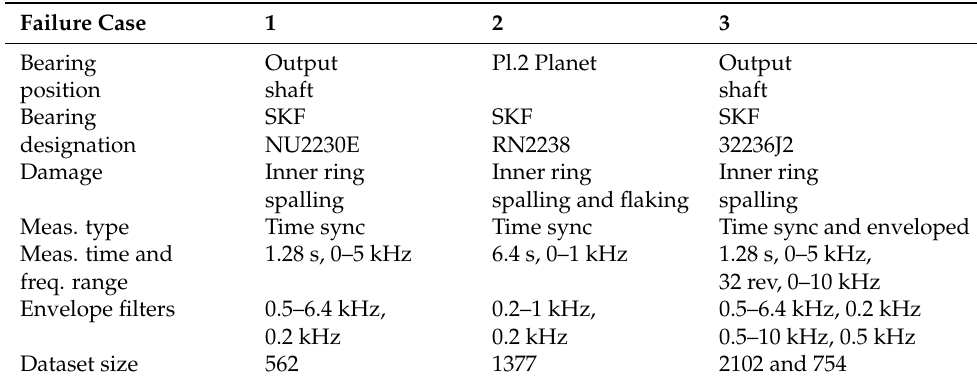
Table 1. Bearing, damage and measurement information for each failure